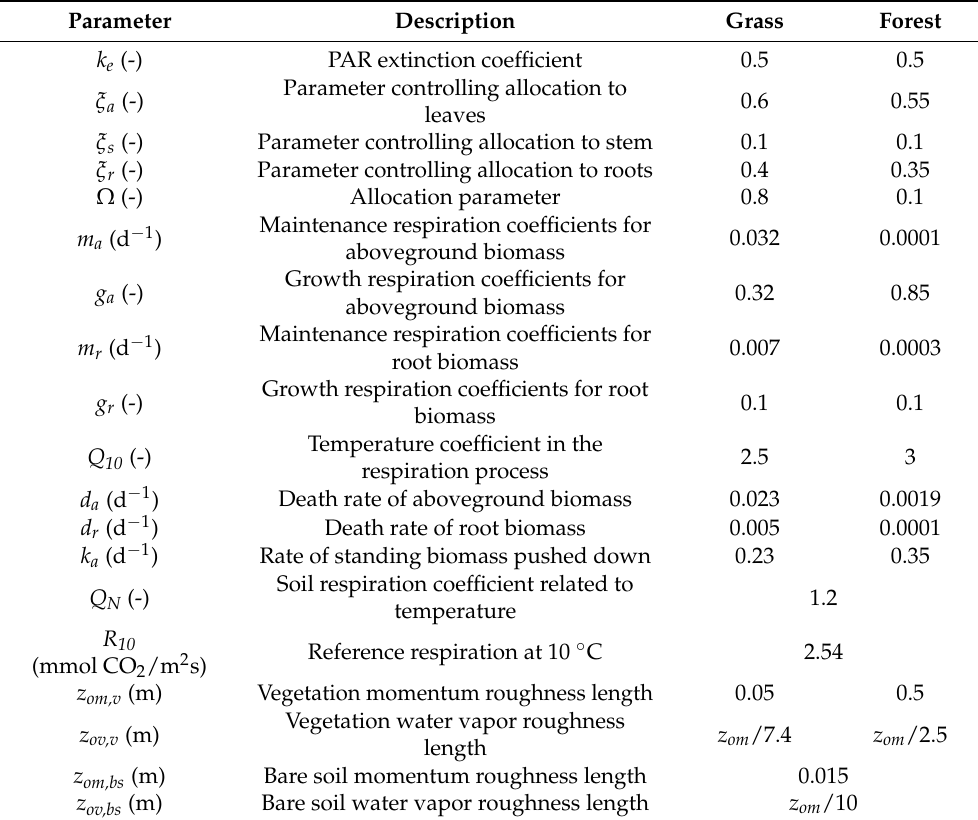
Table 1. Cont. Parameter Description